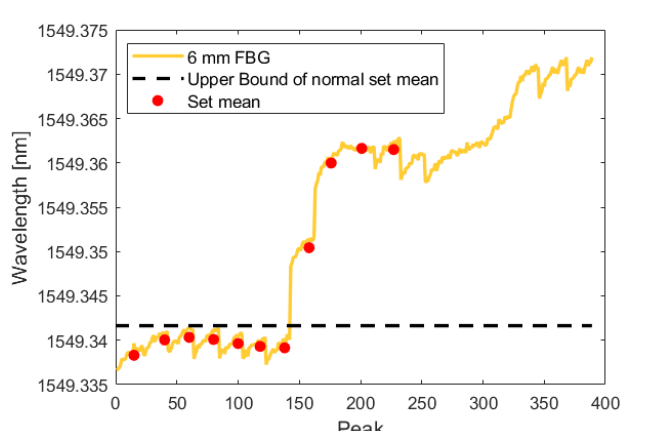
Figure 16. Crack detection analysis during low-amplitude cyclic loading for the FBG embedded 6 mm from the notch tip.